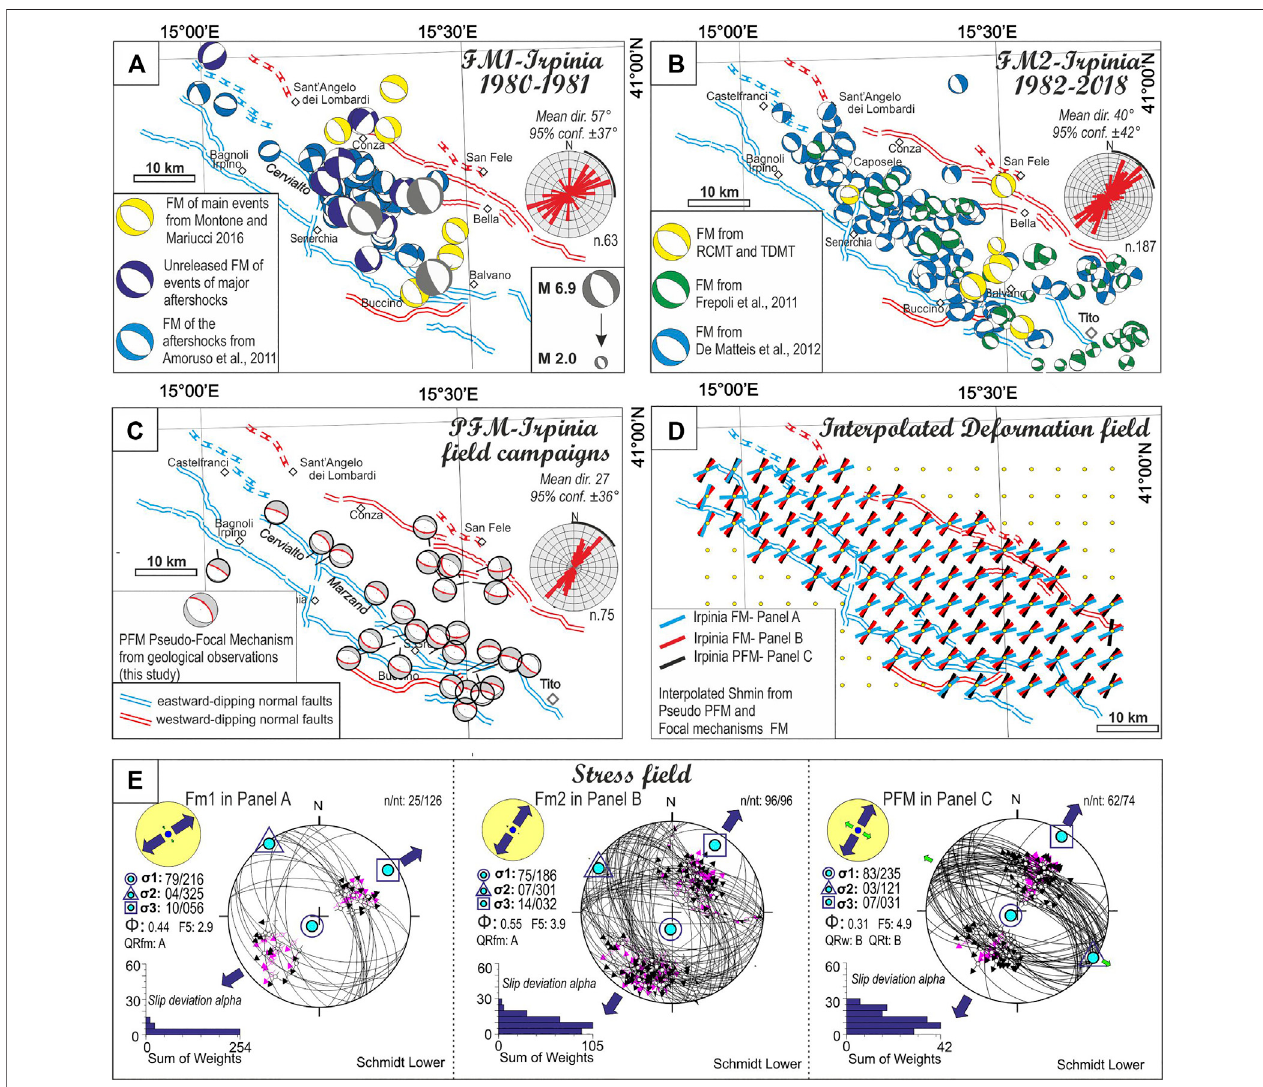
FIGURE 10 | Deformation and stress fi eld of the study area. (A) Focal mechanisms distribution of 1980-EQ seismic sequence. The beach-balls of the main event are from Westaway and Jackson (1987), the major aftershocks (M w > 5.0) from Italian CMT, and the aftershocks from Amoruso et al., 2011. The blue ones refer to Supplementary Data Sheet S3 . (B) Focal mechanisms distribution from 1982 to 2018. Focal mechanisms solutions of the more energetic events (M w ≥ 4.0) are from the Italian CMT and Time Domain Moment Tensor catalog (Scognamiglio et al., 2006), the others are from detailed papers (Frepoli et al., 2011; De Matteis et al., 2012). (C) Pseudo focal mechanisms computed with geological structural data. (D) Deformation pattern from data in Panel A – C opportunely selected for quality. The colored axesrepresenttheresultsoftheinterpolated